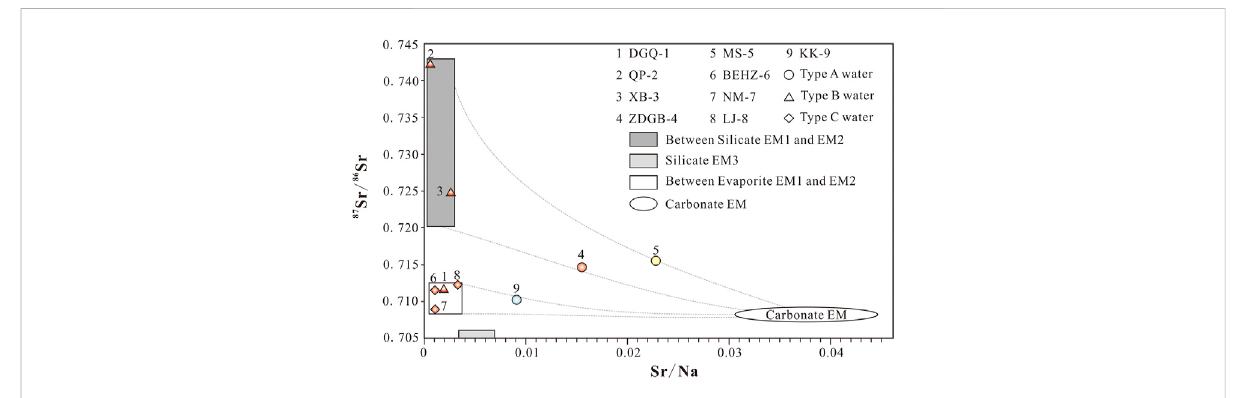
FIGURE 8 Plots of 87 Sr/ 86 Sr versus the corresponding Sr/Na for different spring waters from the KKF. The data for six end-members — silicate – EM1 (Gaillardet et al., 1999; Noh et al., 2009), silicate – EM2 (Xu and Liu, 2010), silicate – EM3 (Gaillardet et al., 1999; Noh et al., 2009), evaporite – EM1 (Liu et al., 2016), evaporite – EM2 (Moon et al., 2007; Xu and Liu, 2010), and carbonate – EM (Xu and Liu, 2010) — are based on lithological characteristics observed in China. The legend is the same as in Figure